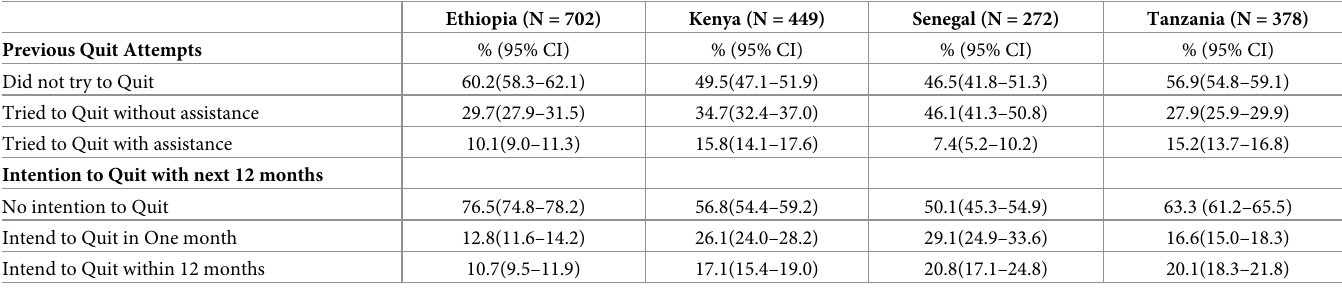
Table 2. Smoking cessation behavior among current smokers across four African